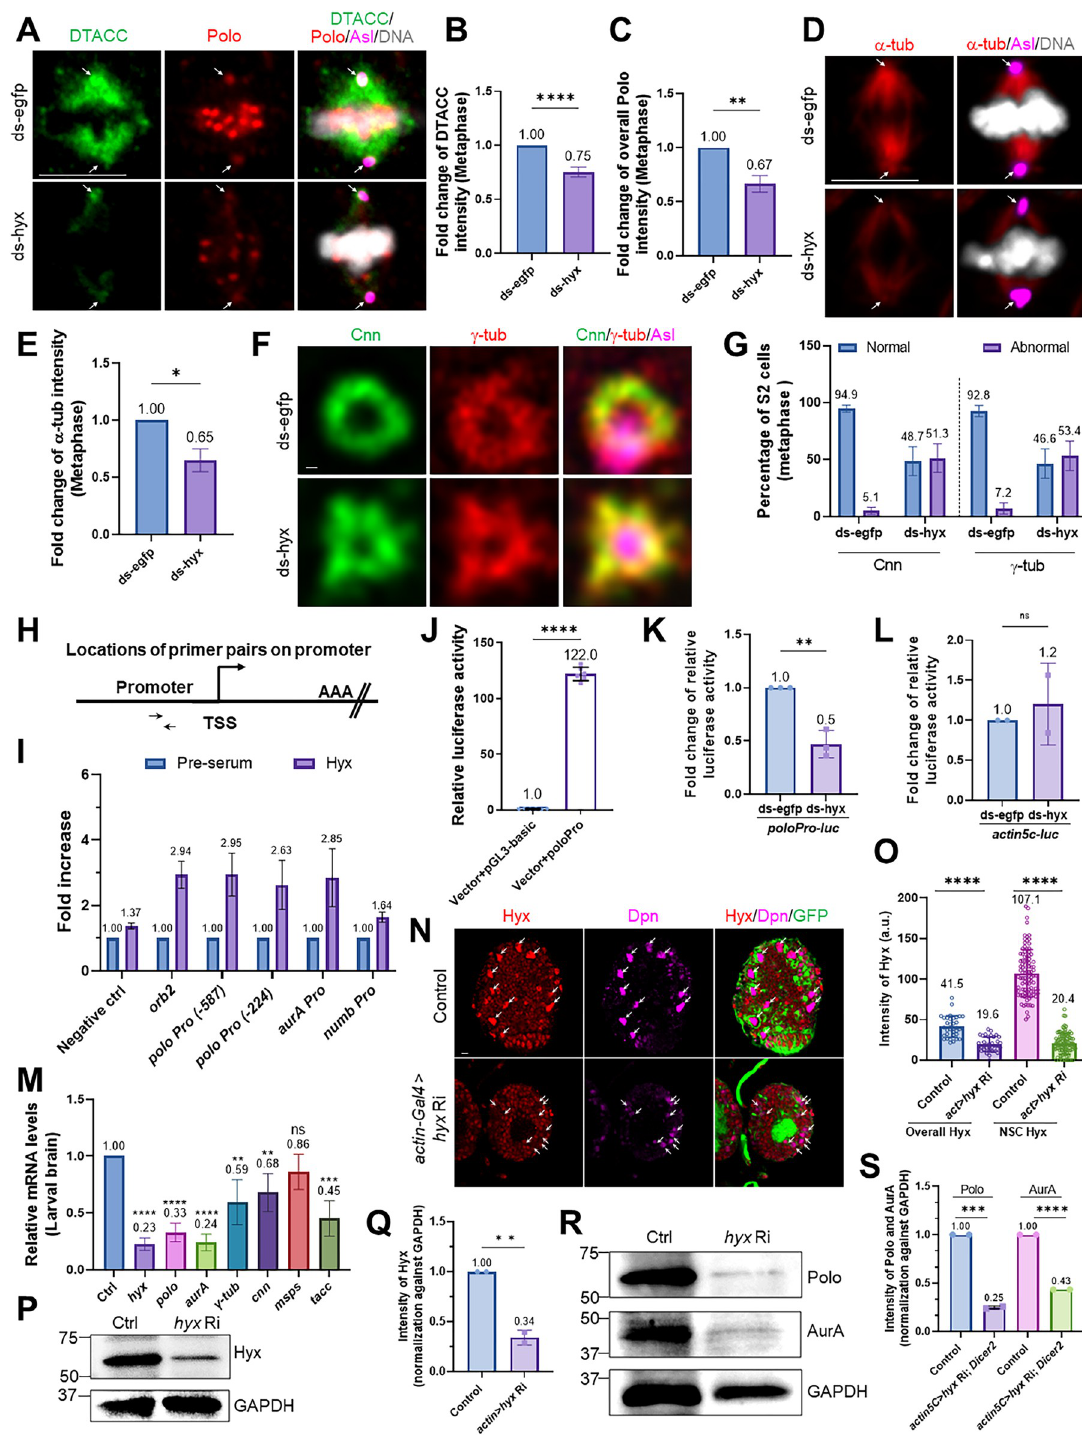
Fig 6. Hyx is required for the recruitment of centrosome-related proteins and directly regulates their expression in vitro. ( A ) Metaphase cells from ds- egfp -treated S2 cells and ds- hyx -treated S2 cells were labeled for DTACC, Polo, Asl, and DNA. ( B ) Quantification graph of the fold change of DTACC intensity (with SD) in S2 cells from A. ds- egfp , 1-fold, n = 66; ds- hyx , 0.75 ± 0.05-fold, n = 69. ( C ) Quantification graph of the fold change of overall Polo intensity (with SD) in S2 cells from A. ds- egfp , 1-fold, n = 77; ds- hyx , 0.67 ± 0.08-fold, n = 81. ( D ) Metaphase S2 cells treated with ds- egfp and ds- hyx were labeled for α -tub, Asl, and DNA. ( E ) Quantification graph of the fold change of α -tub intensity in S2 cells from D. ds- egfp , 1-fold, n = 83; ds- hyx , 0.65 ± 0.10-fold, n = 88. ( F